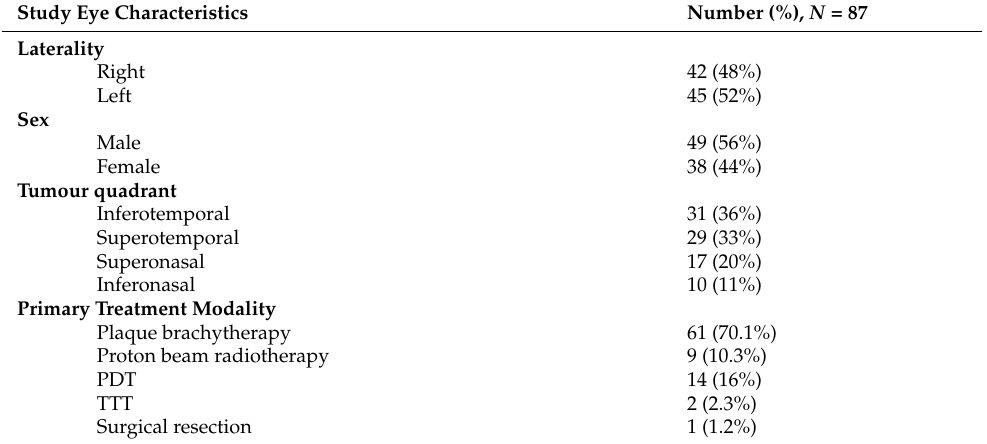
Table 1. Tumour characteristics at diagnosis and the treatment modalities employed for their initial treatment.